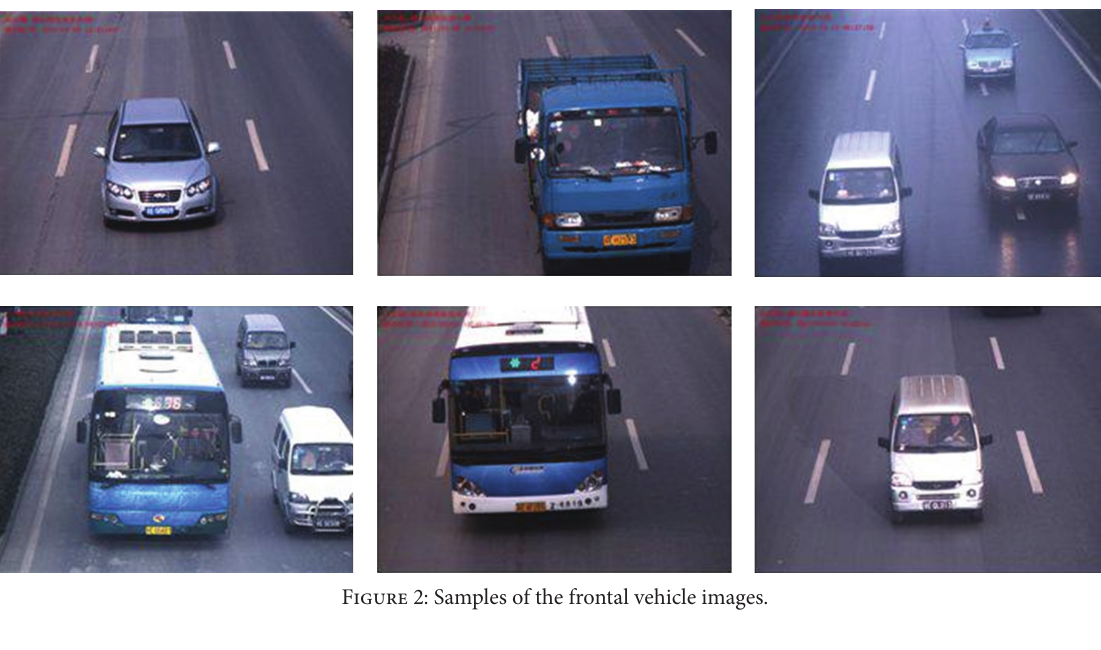
Figure 2: Samples of the frontal vehicle images.